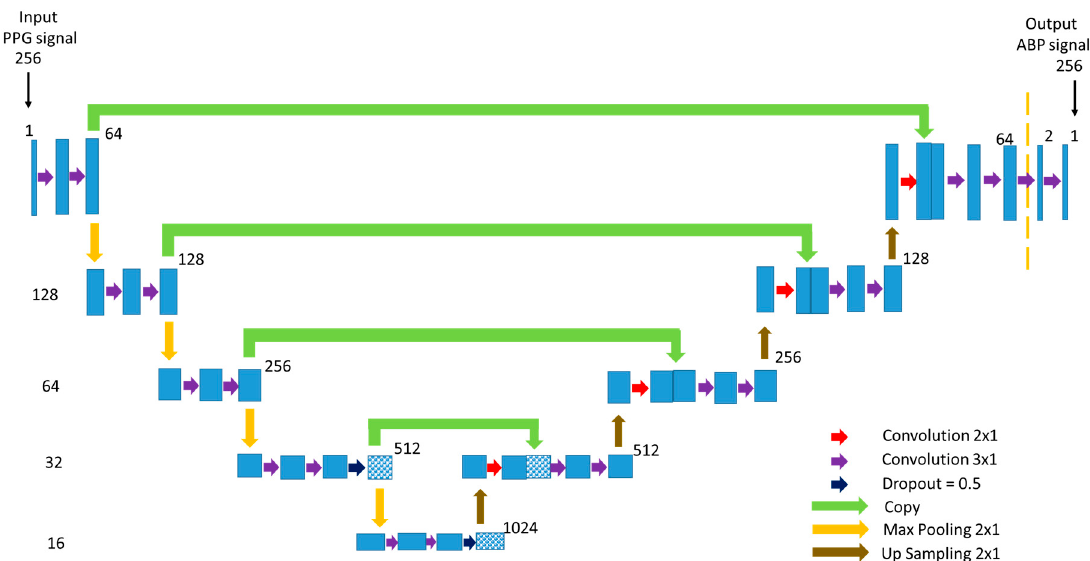
Figure 8. The architecture of the proposed U-net deep learning